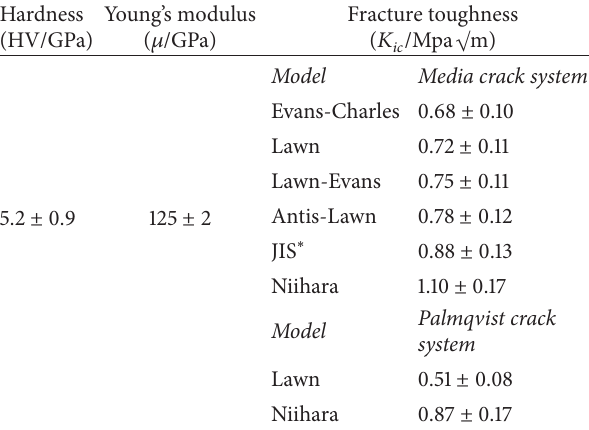
Table 1: Hardness, Young’s modulus, and fracture toughness of ferroelectric